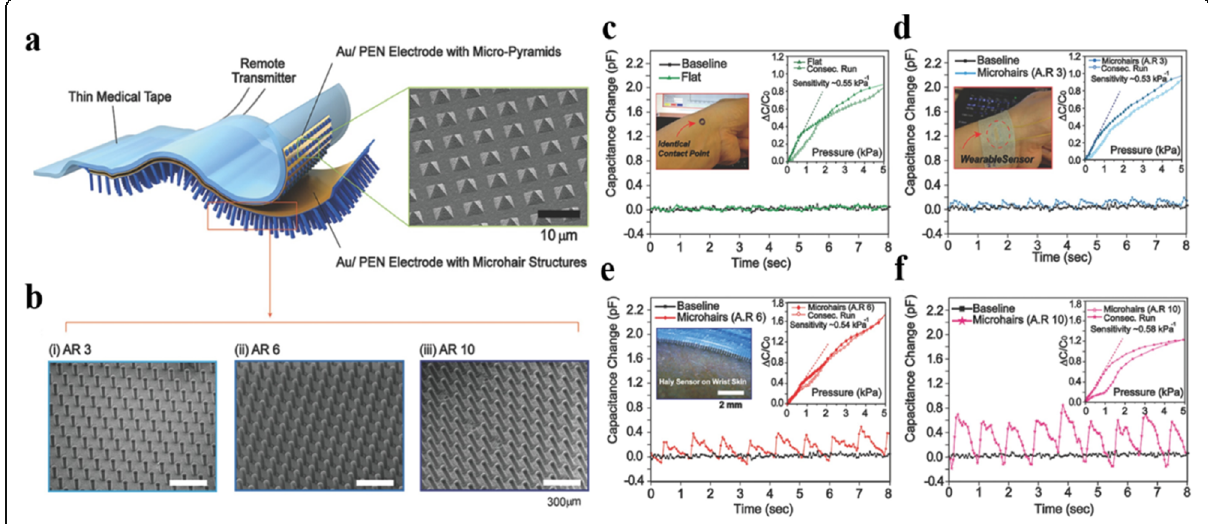
Fig. 5 a Schematic diagram of the microhair-structured sensor. b SEM image of the microhair structure with different aspect ratios. c – f Radial artery test using four devices with different interface geometries: c flat surface, microhairy structure with aspect ratios of d 3, e 6, and f